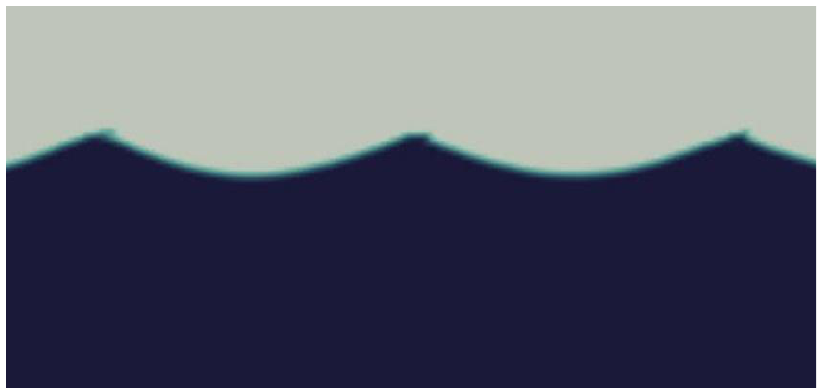
Figure 9. Mild wave breaking noticed in the CFD simulations with H = 0.43 m.